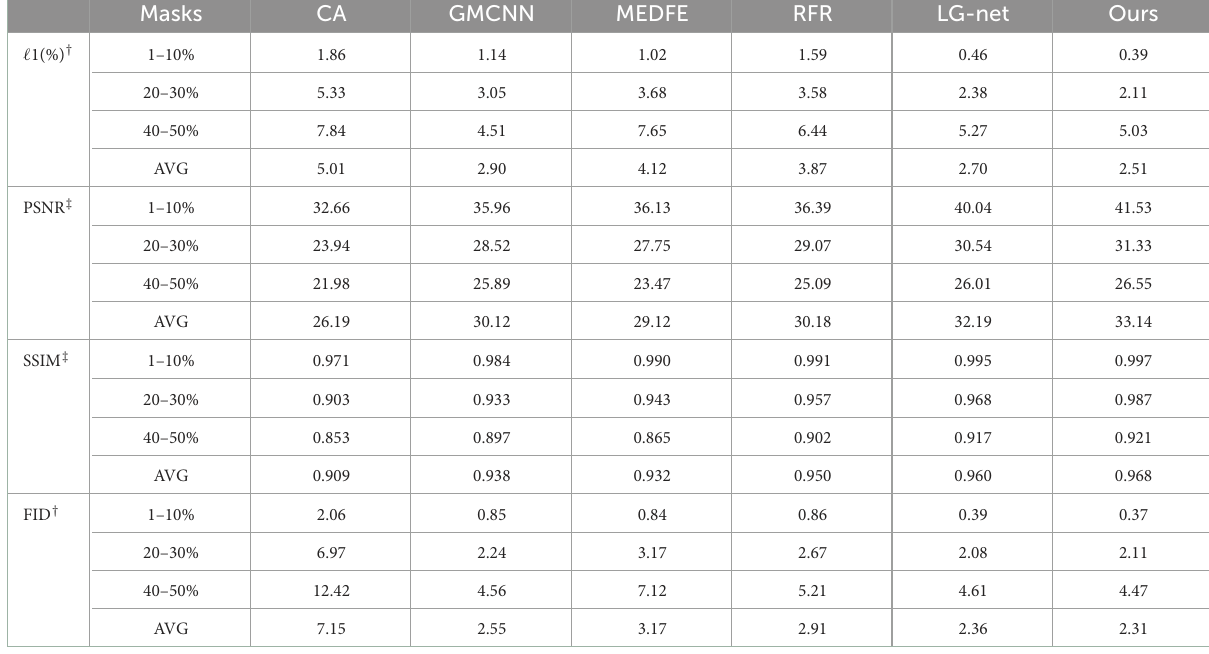
TABLE 2 Quantitative comparisons of ours with the other six methods in CelebA-HQ.